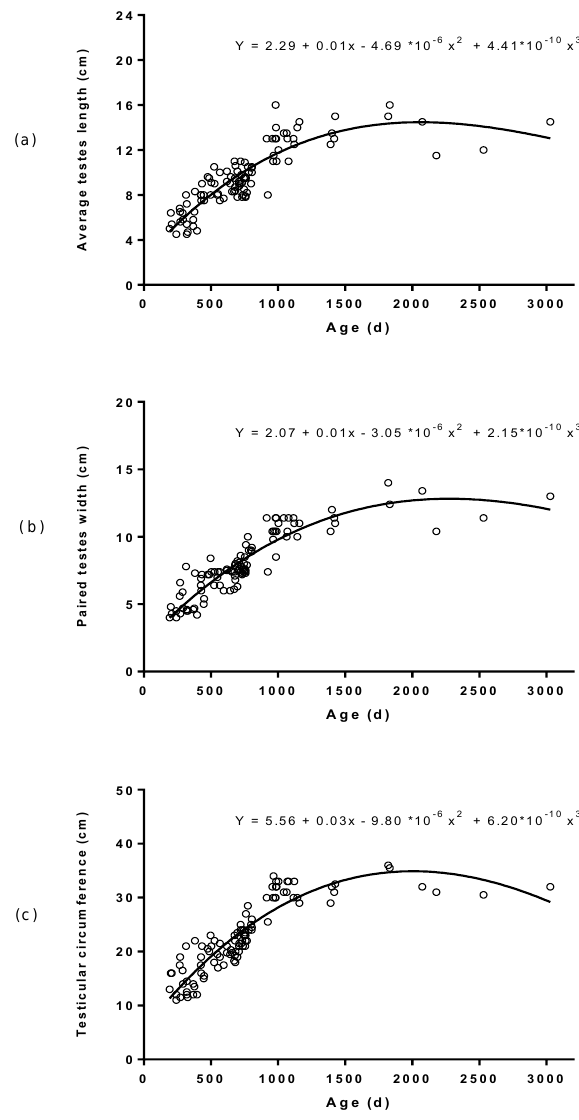
Figure 5. Age-related distribution of average testes length (a) , paired testes width (b) , and scrotal circumference (c) in male Mur- rah buffaloes ( n =